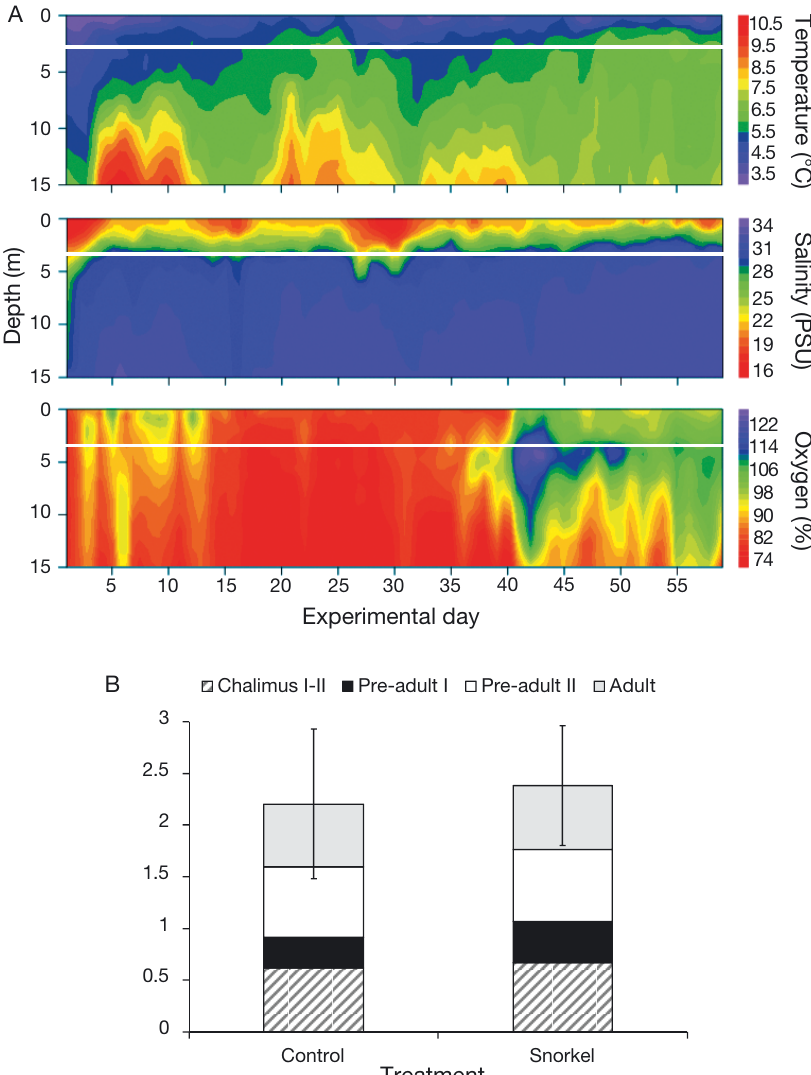
Fig. 2. (A) Continuously recorded vertical temperature, salinity, and oxygen profile of the water column from 0−10 m depth for Expt 2 conducted at a fjord site with a strong halocline (Matredal in Masfjorden) over the 55 d experimen- tal period. Solid white lines: maximum depth (3 m) of the anti-lice barrier. (B) Mean (±SE) abundances of different developmental stages of salmon lice fish −1 at the conclusion of Expt 2. Bars represent the mean of 20 Atlantic salmon in each of 3 lice-barrier or control